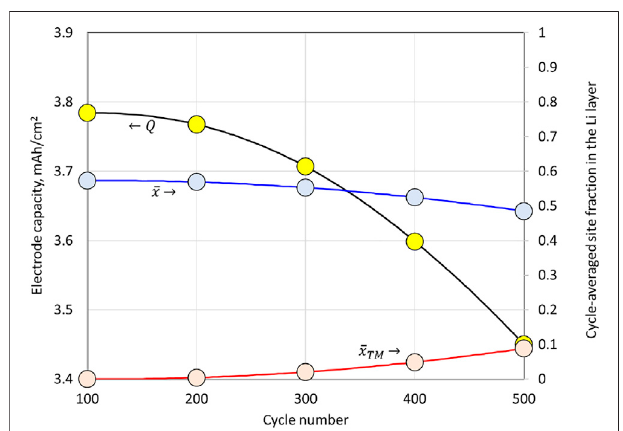
FIGURE 8 | Calculated electrode capacity, Eq. 75 , and cycle-average site fractions, cf. Eq. 76 . The symbols refer to the calculations presented in Figure 7 .